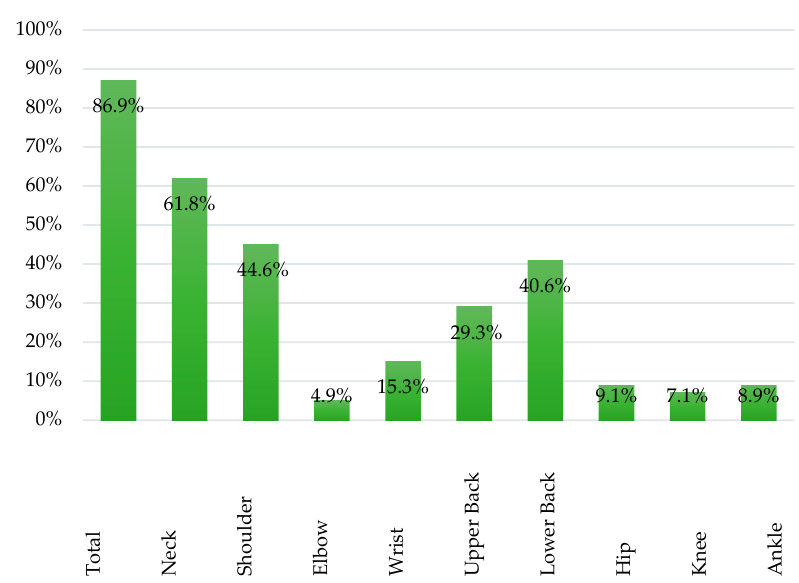
Figure 2. Total prevalence of Musculoskeletal disorder (MSDs) shown in lifetime, 12-month, and seven-day prevalence (in %).